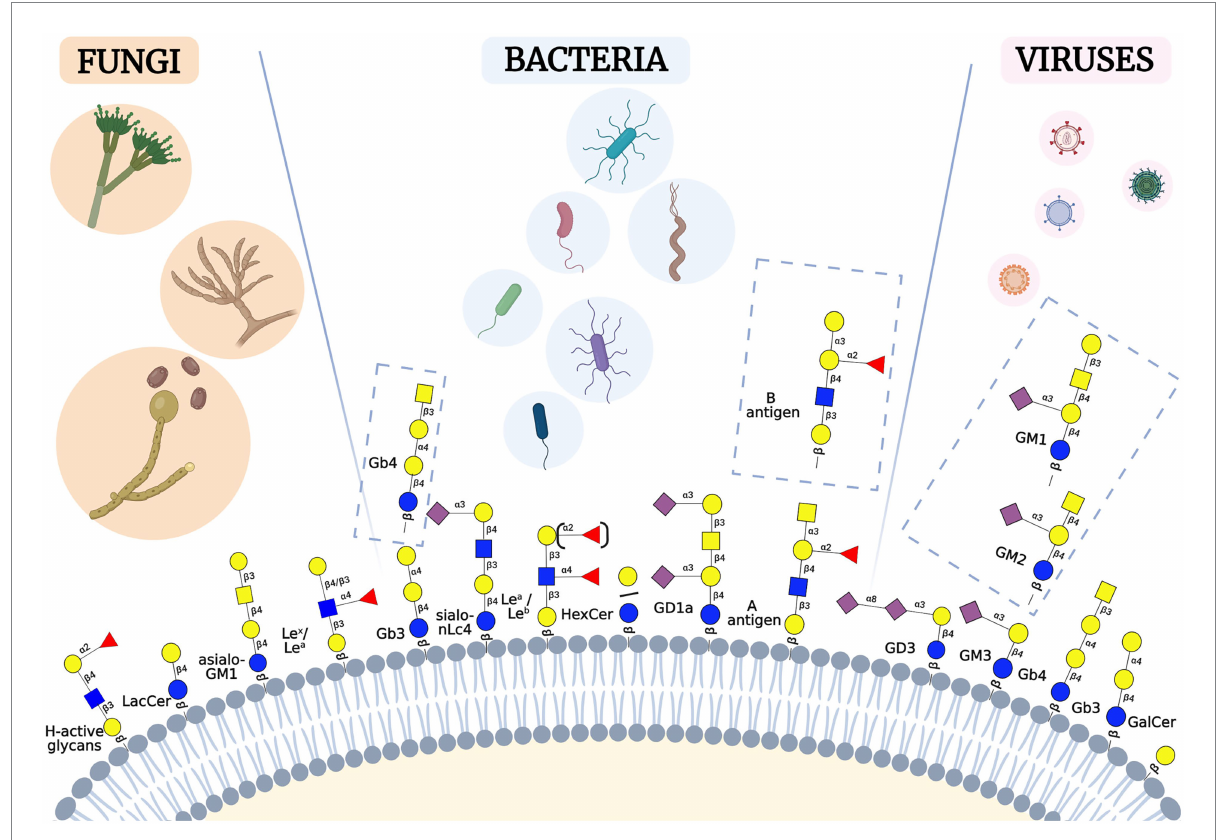
FIGURE 3 Schematic representation of selected GSLs involved in host-pathogen interactions. Fungi, bacteria and viruses may bind various types of GSLs residing in the human membranes. These GSLs belong to different GSL-series, such as asialo, lacto, neolacto, ganglio [Figure was created with